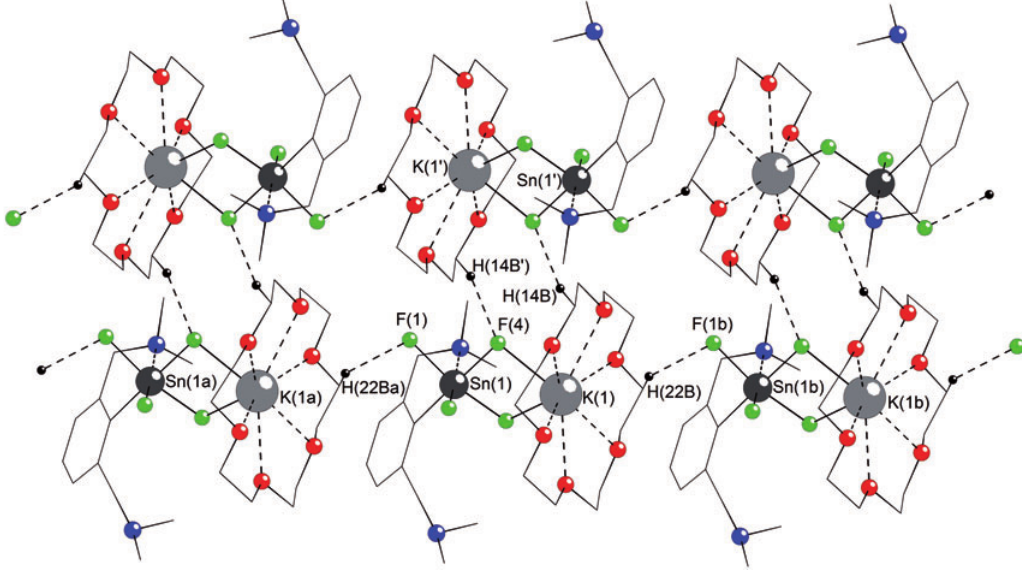
Figure 3 View of the supramolecular ribbon-like association based on intermolecular hydrogen bonding (only hydrogen atoms involved in intermolecular interactions are shown) in the [K(18-crown-6)] + [{2,6-(Me 1-z ), ( x, 1 + y, z ) and ( x,-1 + y, z ) are given by ‘ prime ’ , ‘ a’ and ‘ b ’ ].